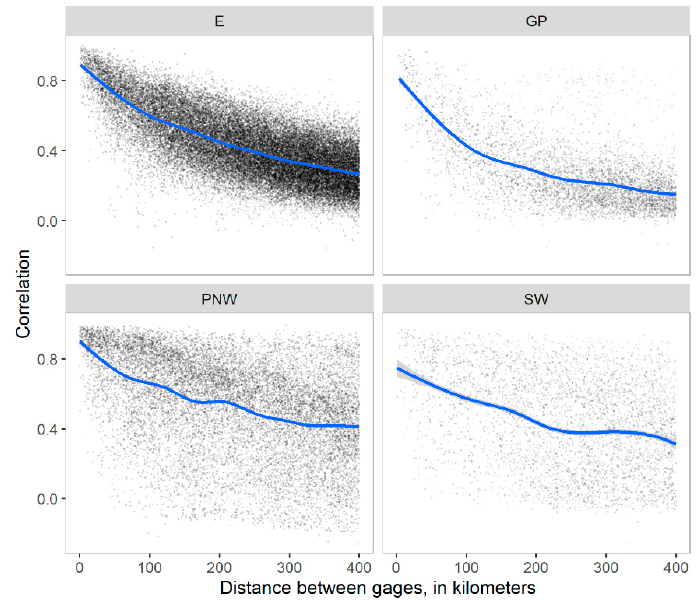
Figure 7. Distance between streamgages and correlation in daily streamflow for four regions in the study area: Eastern U.S. (E), Great Plains (GP), Pacific Northwest and mountains (PNW), and Southwest (SW). Blue line is a smoothed conditional mean.